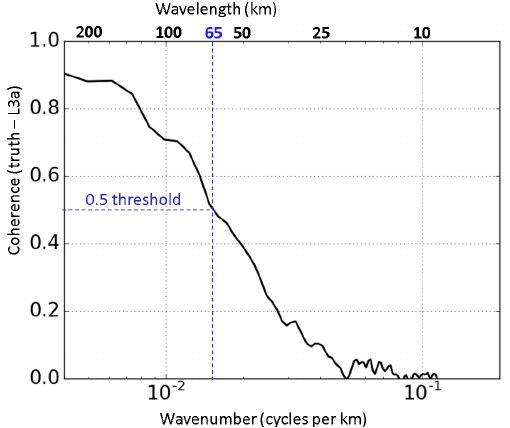
Figure 8. Average coherence of simulated SKIM Level 3a current with the “truth” provided by MITgcm simulations, in the case of the Gulf Stream, for October